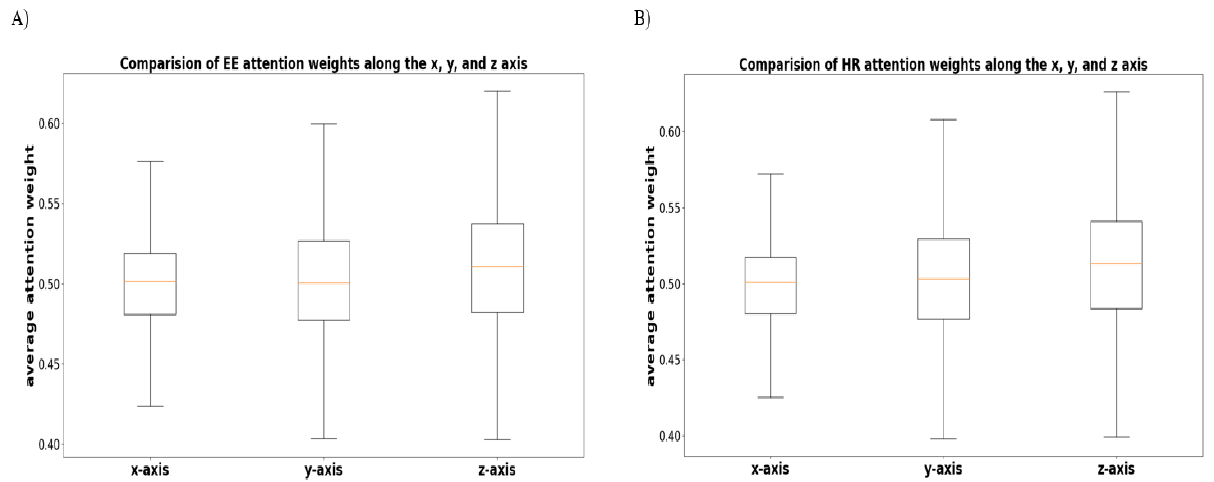
Figure 15. Comparison of the average attention weights for each of the x, y, and z axes. ( A , B ) illustrate the result of EE and HR,